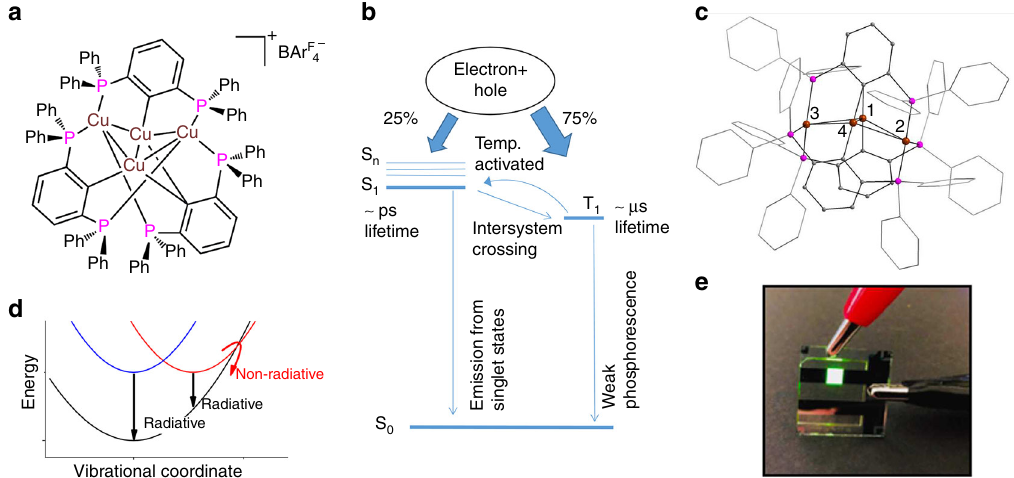
Fig. 1 Temperature-activated delayed fl uorescence: system and processes. a [Cu 4 ( PCP ) 3 ] + ( PCP = 2,6-(PPh 2 ) 2 C 6 H 3 ) complex. b Scheme of light emission from Cu-based OLEDs due to temperature-activated delayed fl uorescence (TADF) under electroluminescence conditions. After electron-hole recombination, the singlet and triplet excited states are occupied in a 1:3 ratio due to one possible momentum projection in the singlet and three possible projections in the triplet state. If the energy of the triplet state T 1 is close to the energy of the singlet S 1 , temperature-activated reverse intersystem crossing (T 1 → S 1 ) occurs which is followed by light emission from the singlet state. c Structure of [Cu 4 ( PCP ) 3 ] + derived from single crystal X-ray diffraction. Cu atoms are brown, P atoms are magenta, C atoms are gray, H atoms are not shown. d Schematic illustration showing that non-radiative relaxation paths in Cu OLED materials are more probable if equilibrium excited and ground state structures are displaced along some vibrational coordinates. e Green emission from an OLED prototype with [Cu 4 ( PCP ) 3 ] + as a